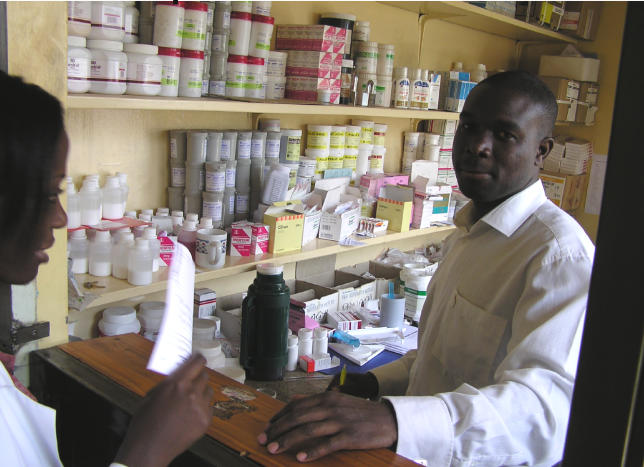
The pharmacy at the Infectious Diseases Institute(Photo: R. Colebunders)